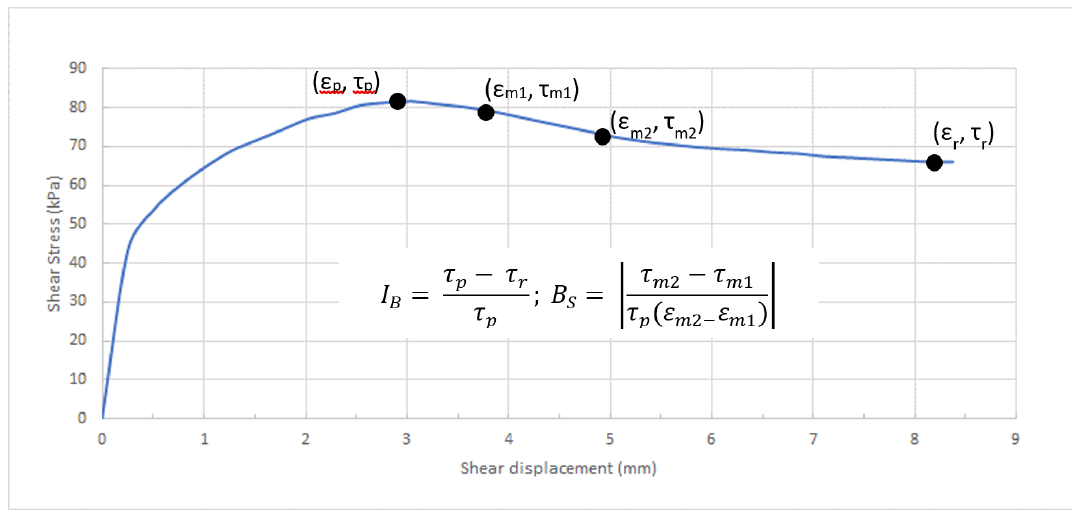
Figure 4. Brittleness Index for Strength